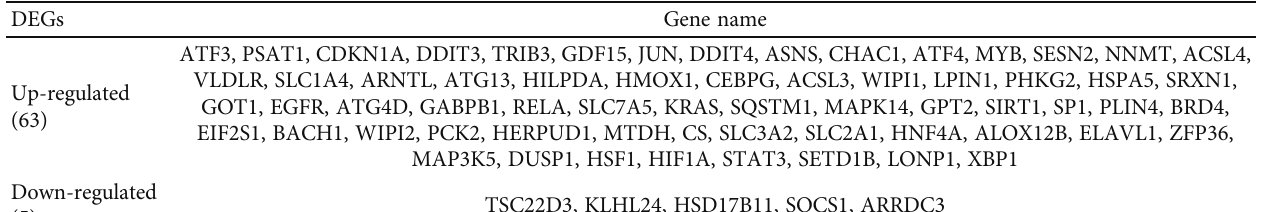
Table 1: Common DEGs of GSE29929 and